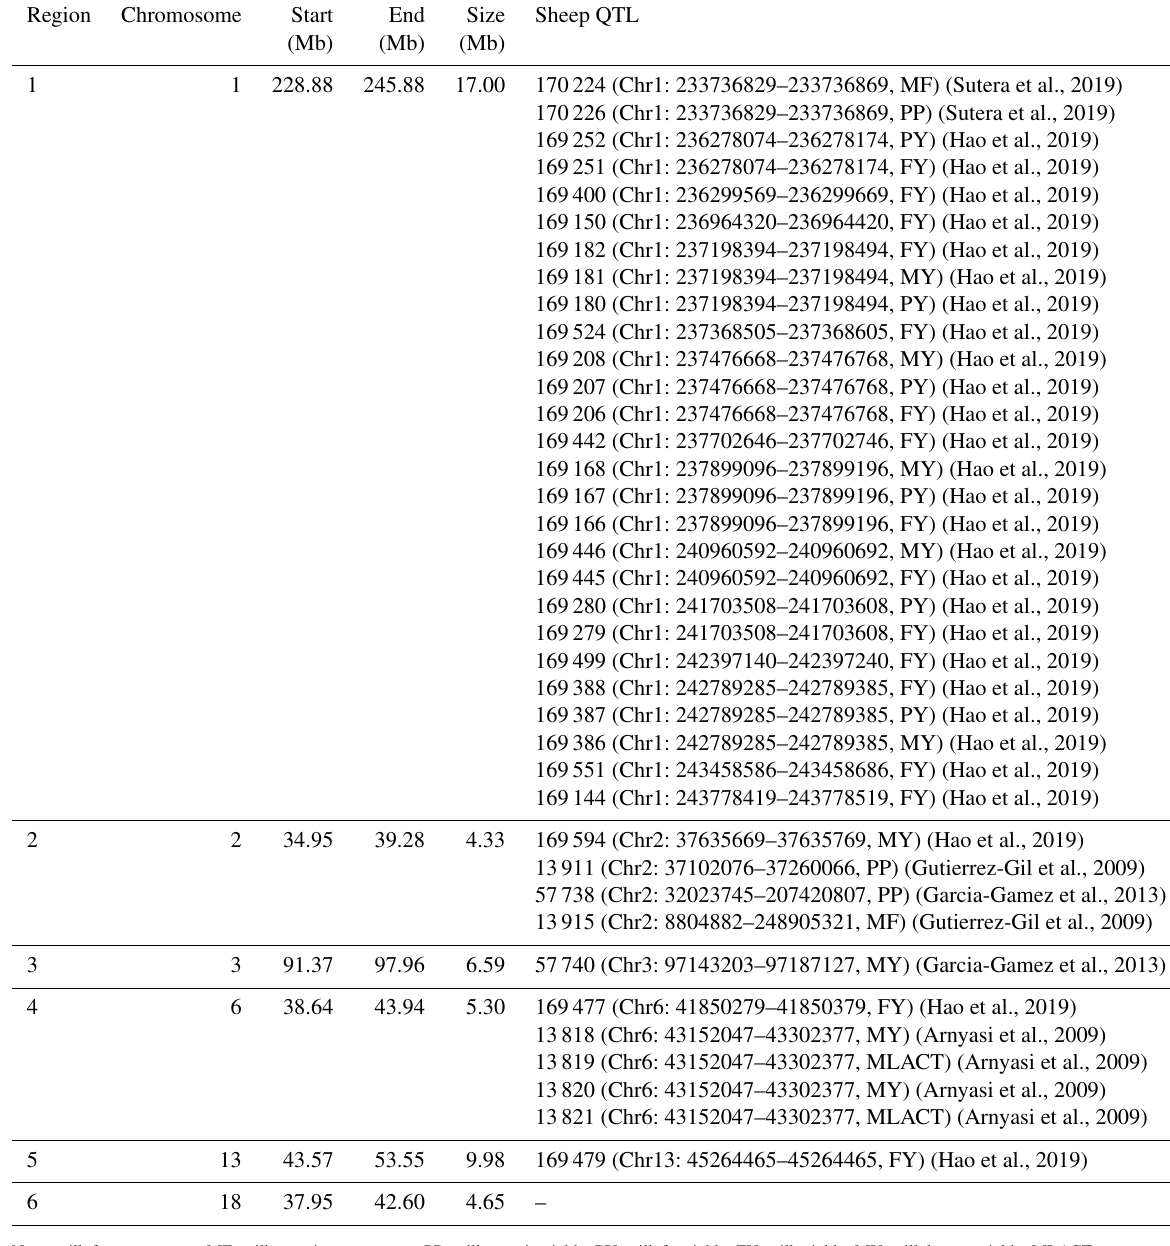
Table 1. Milk-related QTLs located in selection regions. Region